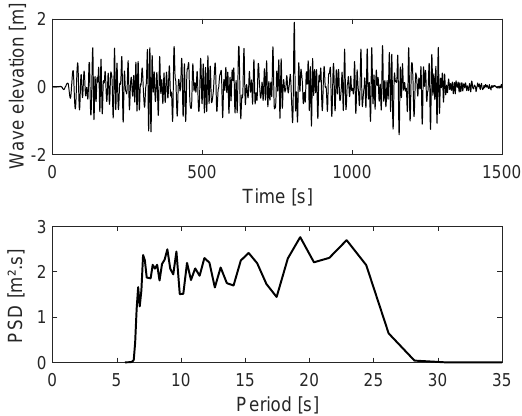
Figure 4. White noise wave type